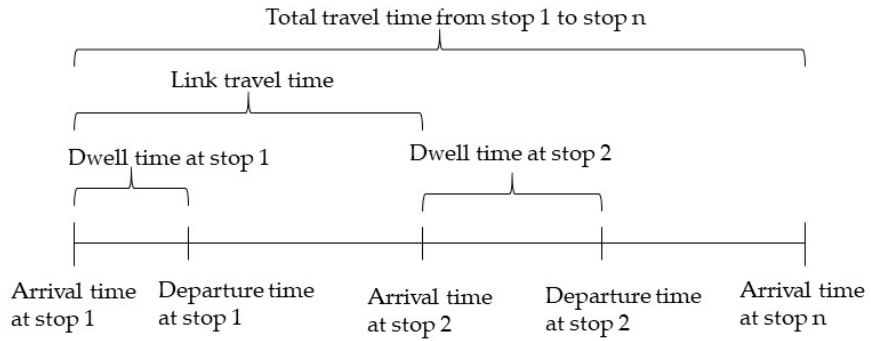
Figure 1. Notation on bus travel time [28].